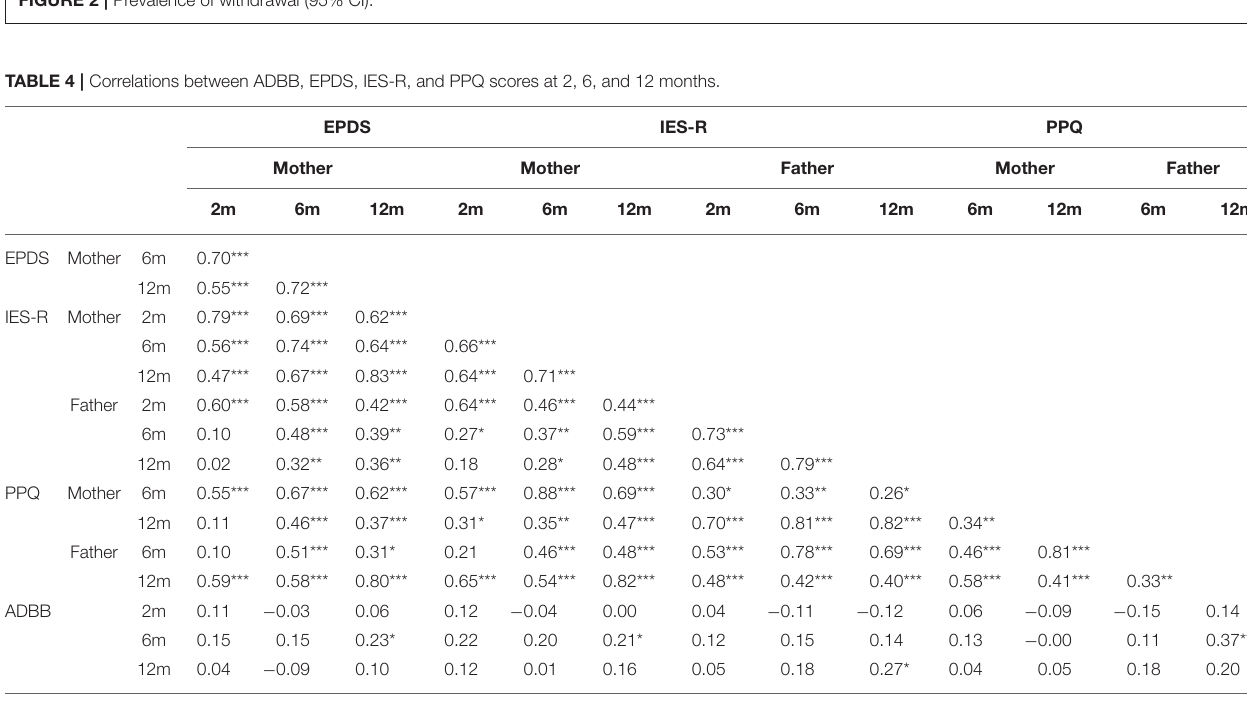
FIGURE 2 | Prevalence of withdrawal (95% CI).